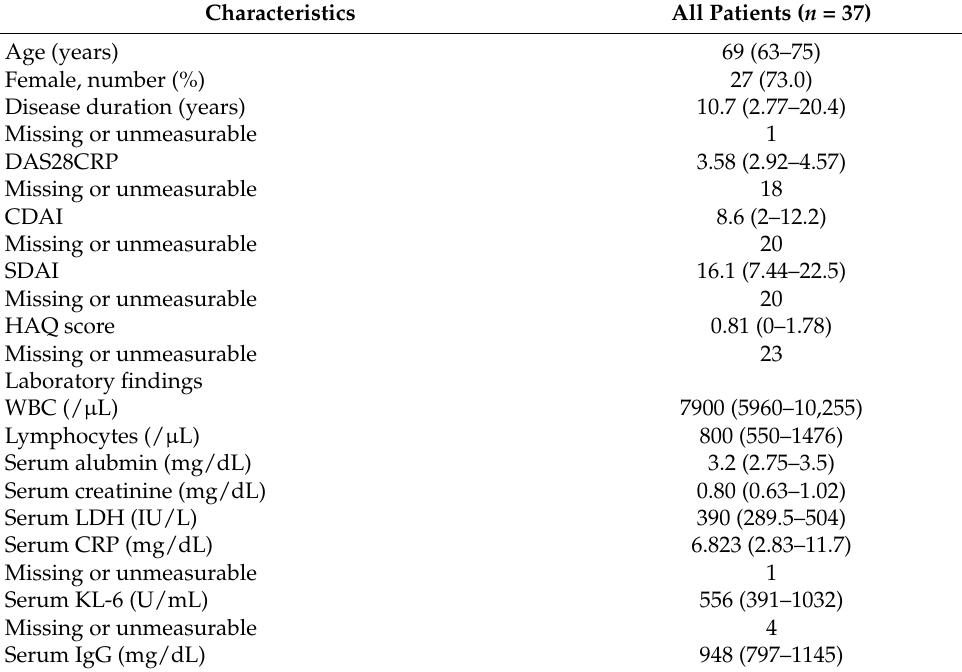
Table 1. Characteristics of the subjects at baseline.